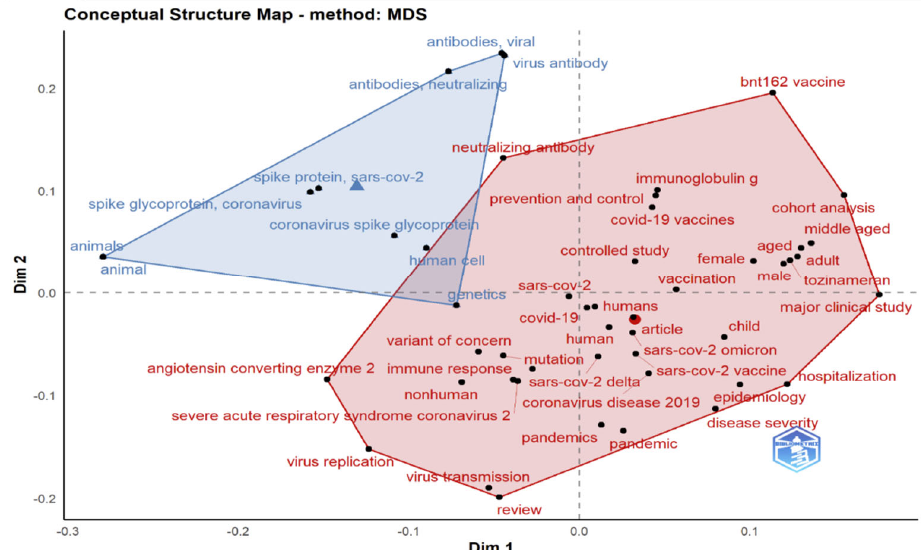
Figure 22. Conceptual structure map using multidimensional scaling that integrates and correlates the knowledge of current studies on